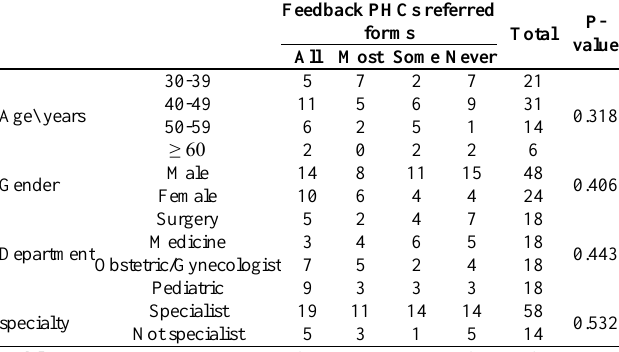
Table 4: Association between feedback PHCs referred forms &